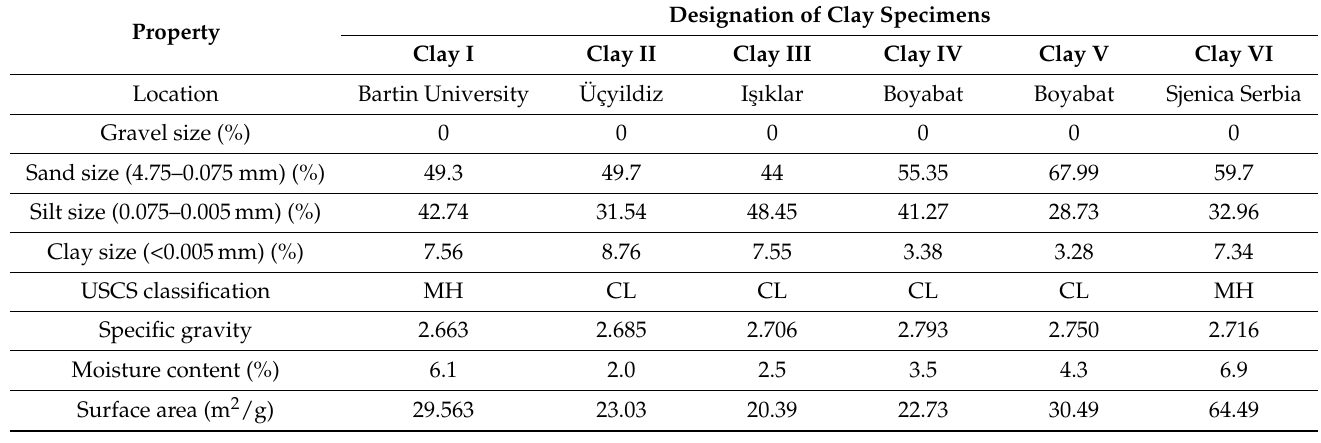
Table 1. Physical properties of clay specimens.